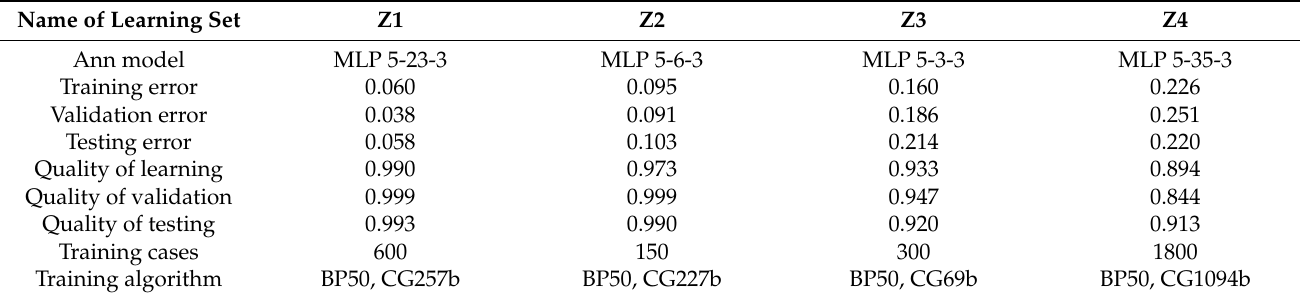
Table 2. Network training